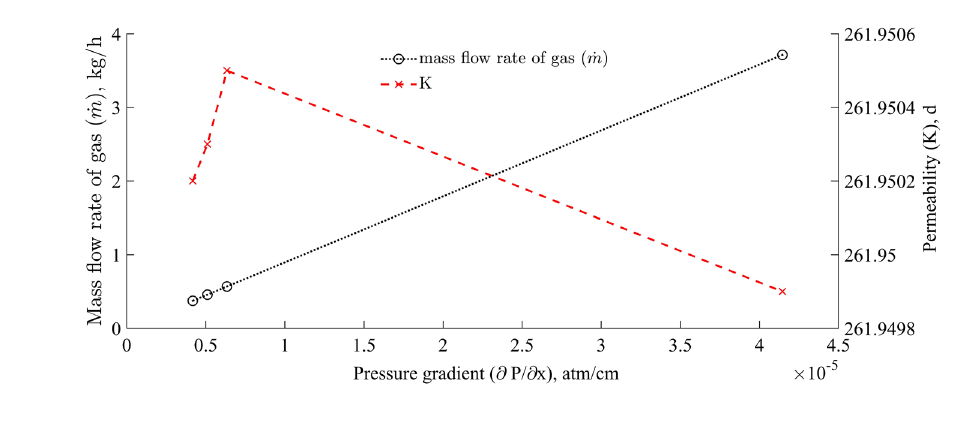
Fig. 9. The effect of dynamic viscosity (μ) on the mass flow rate of volatile gas ( pressure gradient.